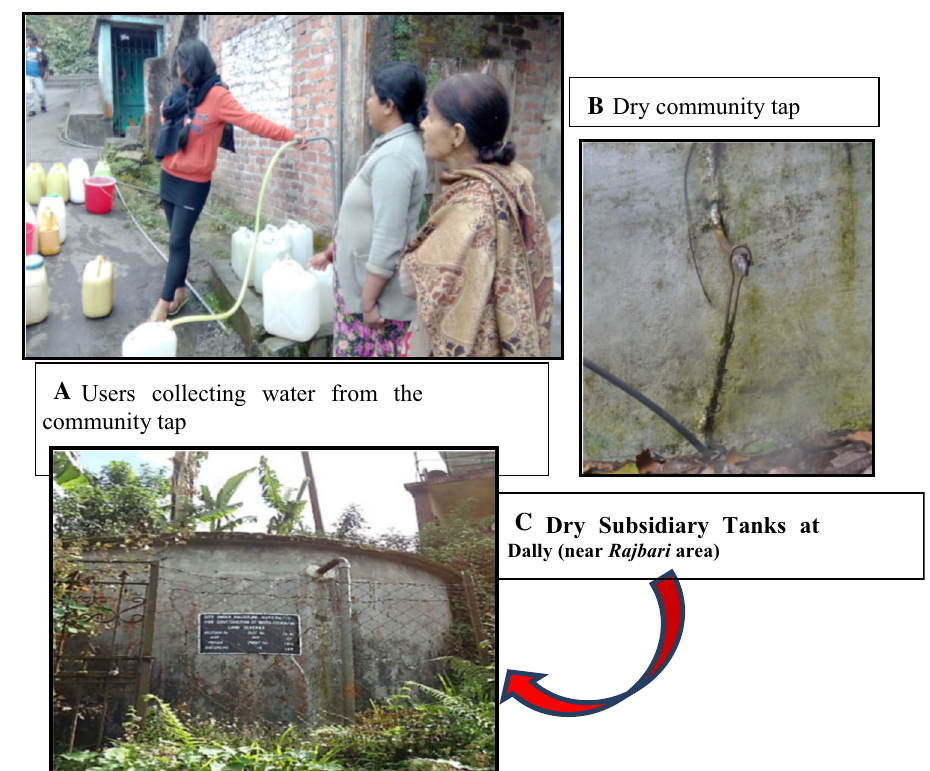
Fig. 3 Glimpses of water